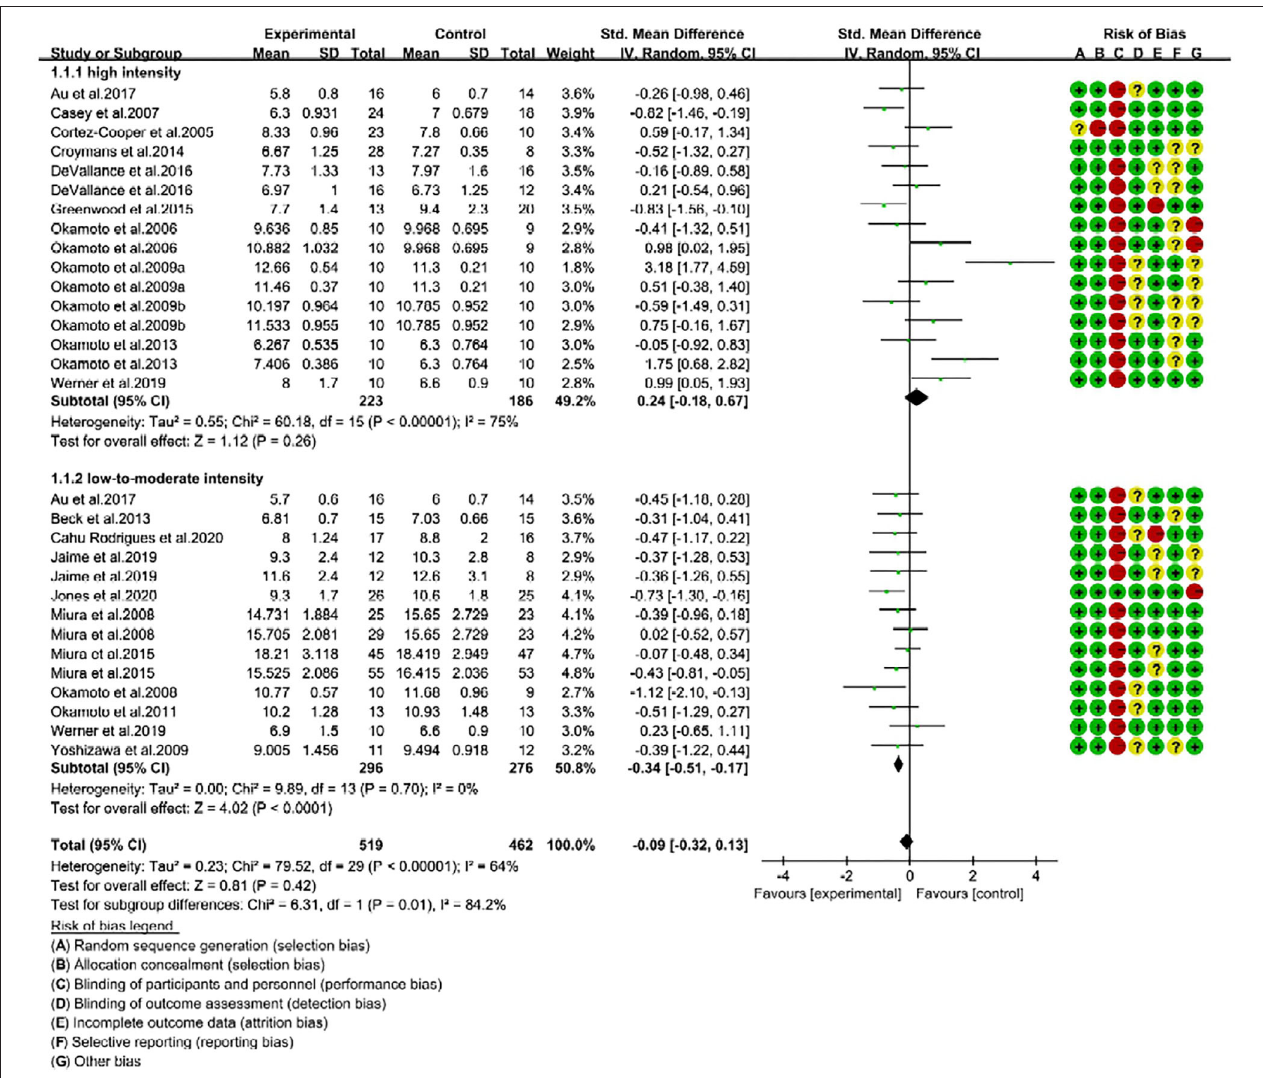
FIGURE 2 | Forest plot of pulse wave velocity (PWV) changes with different intensities of RE in adults (m/s). SD, standard deviation; IV, inverse variation; CI, confidence interval; df, degrees of freedom. Risk of bias: green ( + ) indicates low risk of bias; red (–) high risk of bias; and yellow (?) unclear risk of bias.